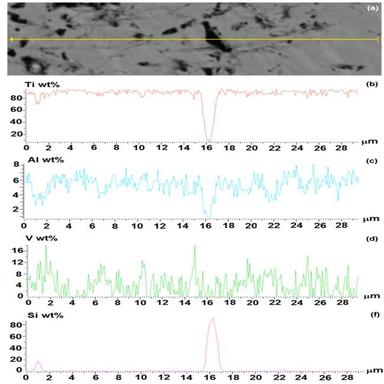
(a) SEM image used to EDX analysis of Ti6Al4V from the top showing the (b-f) variation in the chemical composition (wt %) along with the microstructure.